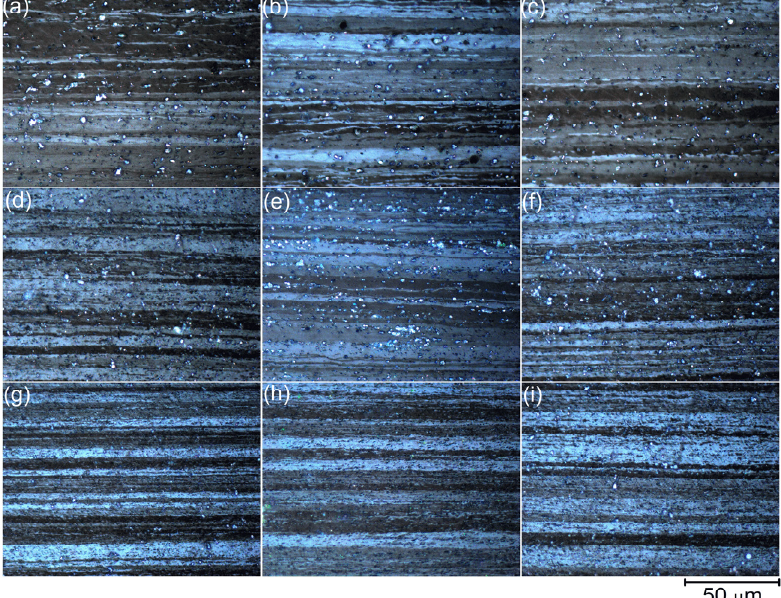
Figure 6. Grain structure of the ( a – c ) 0Ce, ( d – f ) 2Ce, ( g – i ) 4Ce alloy sheets after 20 min annealing at ( a , d , g ) 460 °C, ( b , e , h ) 480 °C, ( c , f , i ) 500 °C. ( a , d , g ) 460 ◦ C, ( b , e , h ) 480 ◦ C, ( c , f , i ) 500 ◦